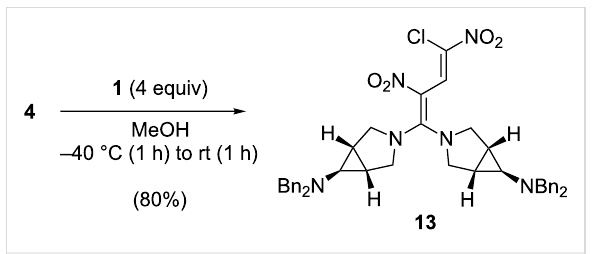
Upon treatment of 1,3-dinitro-1,4,4-trichlorobutadiene ( 4 ), which was obtained in a four-step sequence from 1,2- dichloroethylene (mixture of diastereomers) [20,21], with a fourfold excess of the azabicyclo[3.1.0]hexane 1 in methanol at − 40 °C, a twofold vinylic substitution led to the 4,4- bis(aminoazabicyclo[3.1.0]hexyl)-1-chloro-1,3-dinitrobuta- diene 13 in 80% yield (Scheme